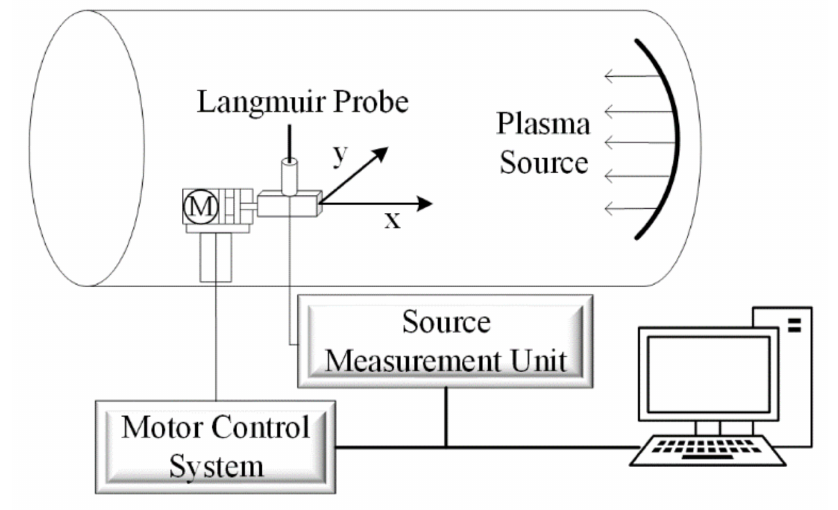
Figure 6. Experimental